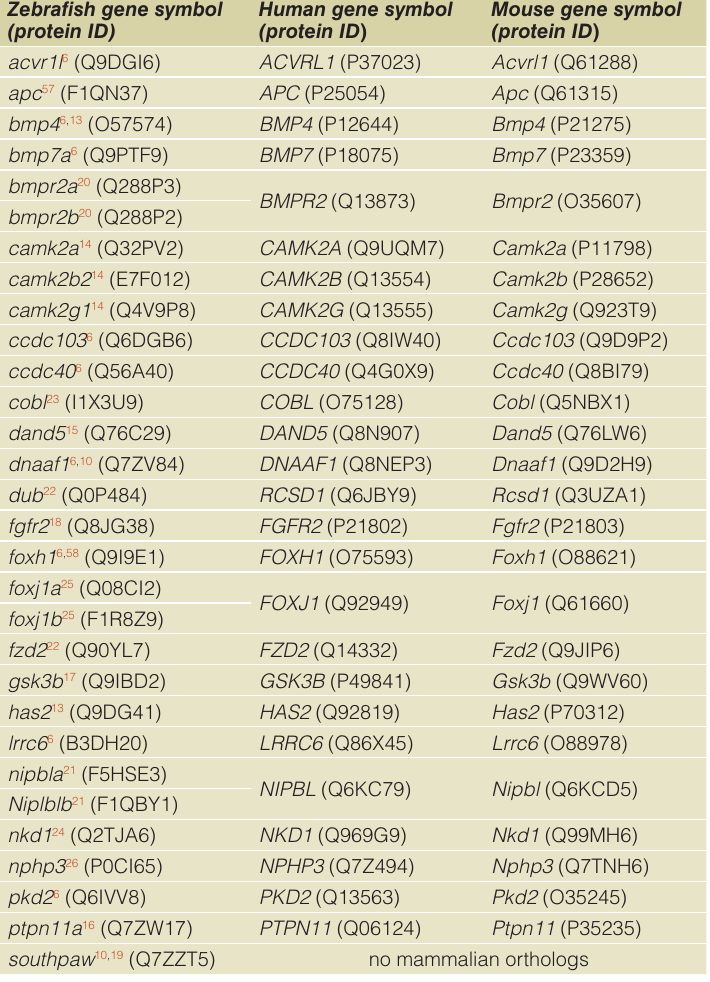
Table 1. Proteins included in zebrafish ‘jogging’ gene list and the human and mouse ‘jogging ortholog’ gene lists. The evidence for these 30 zebrafish proteins having a role in heart jogging comes from mutant, morpholino or functional complementation studies, as described in the associated publications. Zebrafish gene symbol (protein